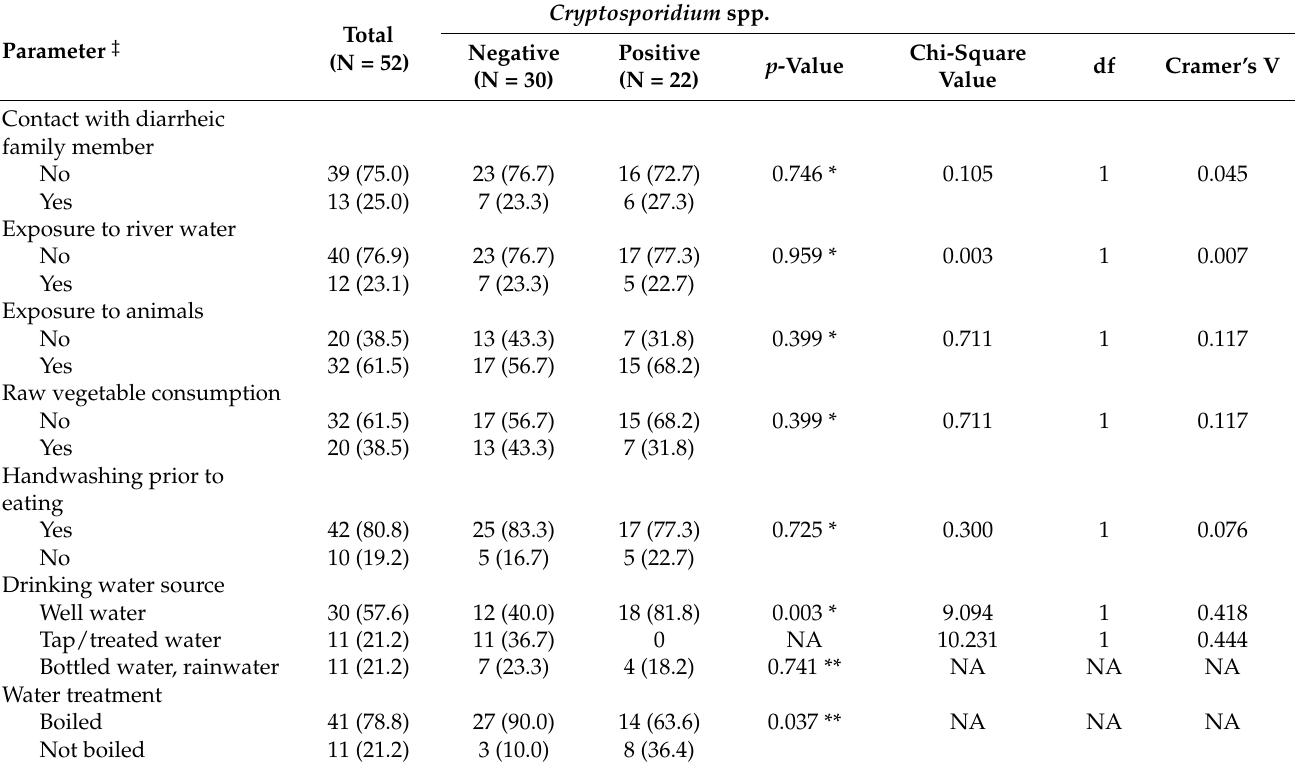
Table 3. Risk factors of Cryptosporidium infection in children living with HIV.